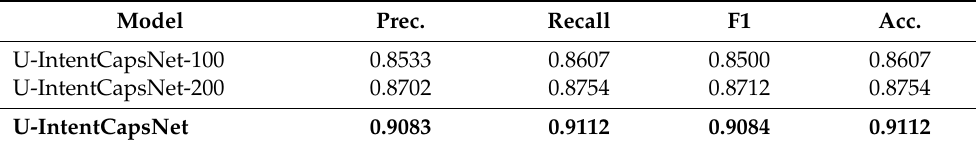
Table 16. Intent detection results by varying dimensionality of input word vector in the proposed U-IntentCapsNet model.